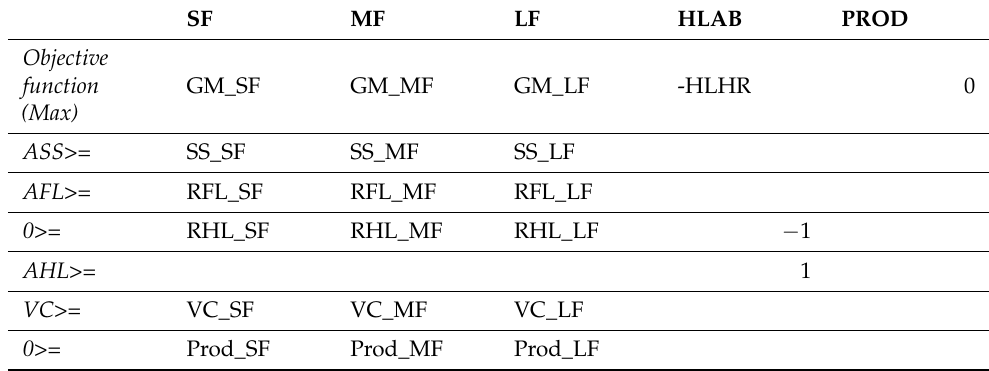
Table 2. Linear programming